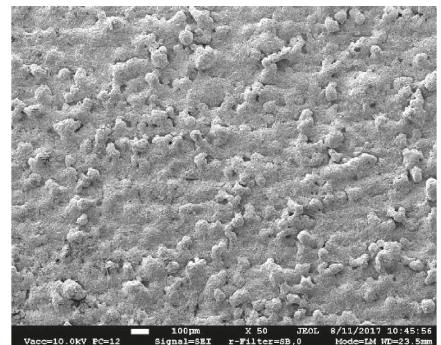
Figure 3: On-side surface morphology of as-sintered SLS